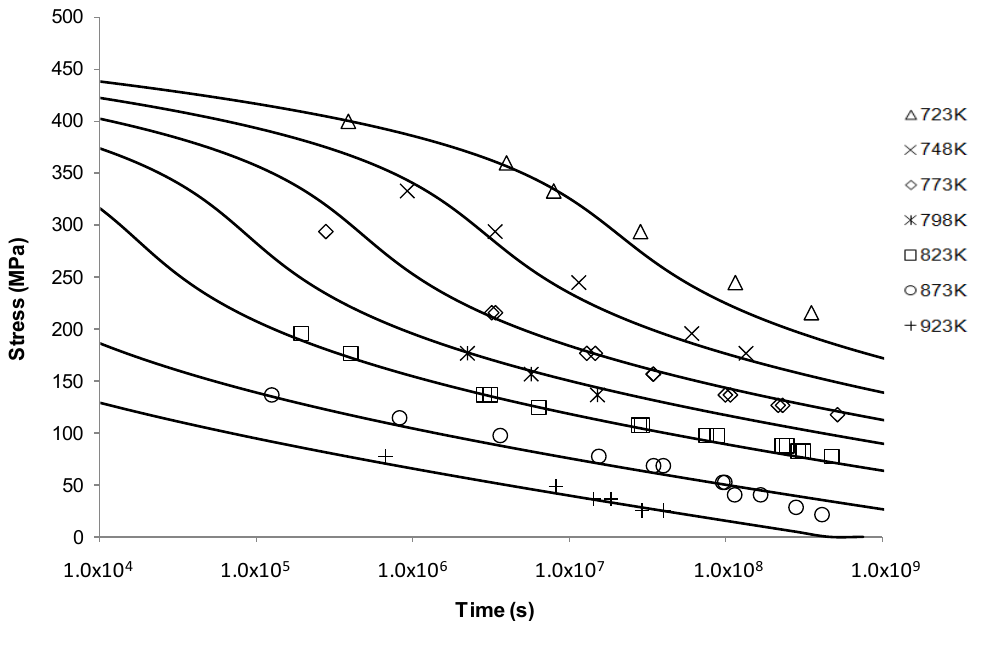
Figure 2. The Larson-Miller’s stress vs . time to fracture predictive curves using Grade 22 Steel creep